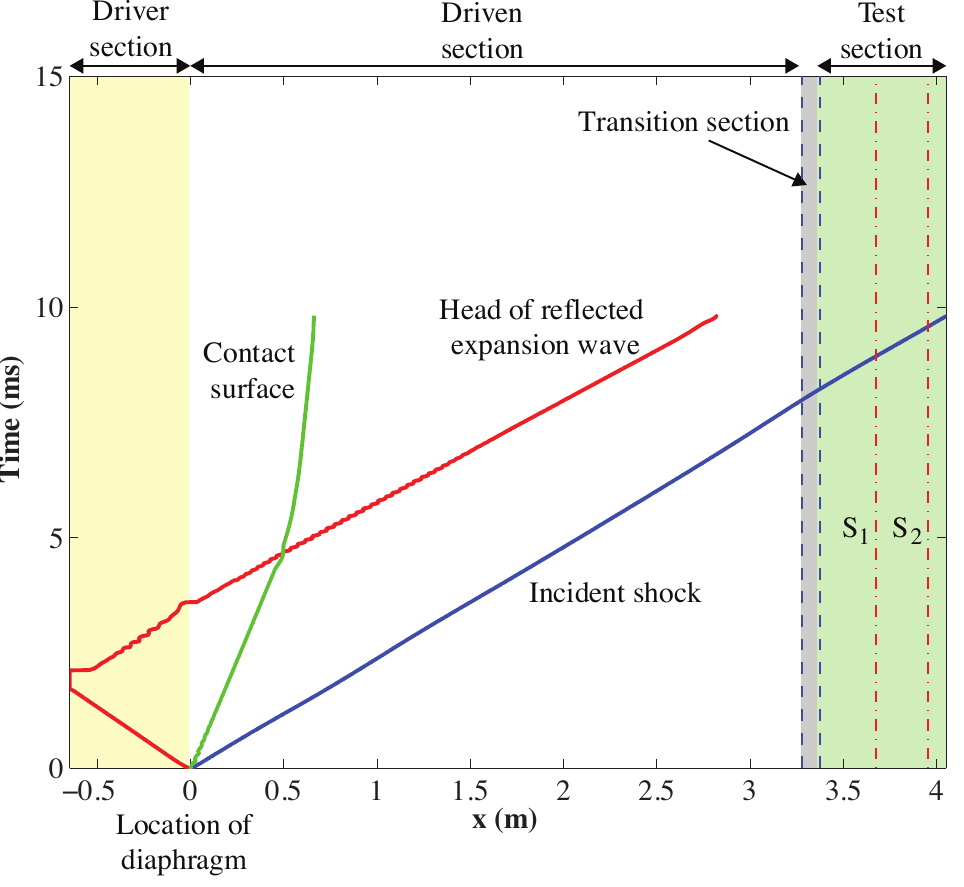
and S are shown with the 1 2